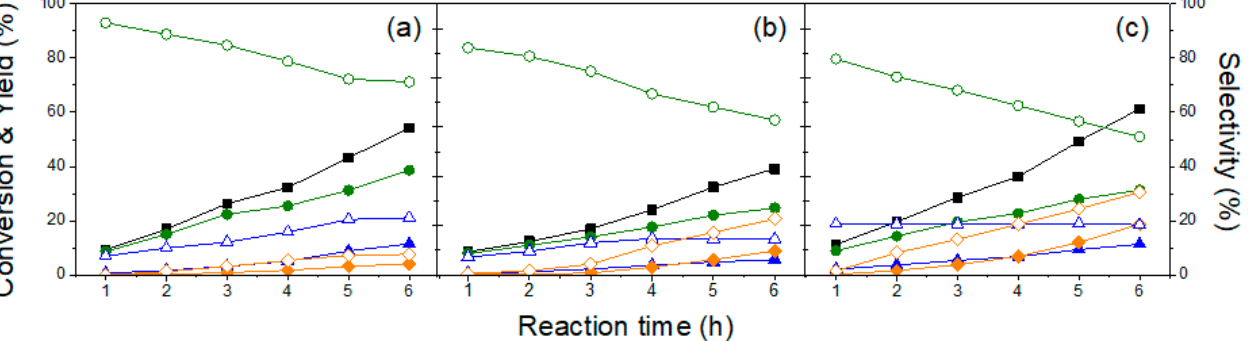
Figure 4. The influence of reaction time on the etherification reaction of glycerol: ( a ) XZ-Li, ( b ) XZ-Na and ( c ) XZ-K (- ■ -: conversion of glycerol, - ● -: yield of DG, - ▲ -: yield of TG, - ♦ -: yield of others - ○ -: selectivity of DG, - Δ -: selectivity of TG, - -: selectivity of others, amount of zeolite: 3 wt.%, reaction temperature: 260 °C).